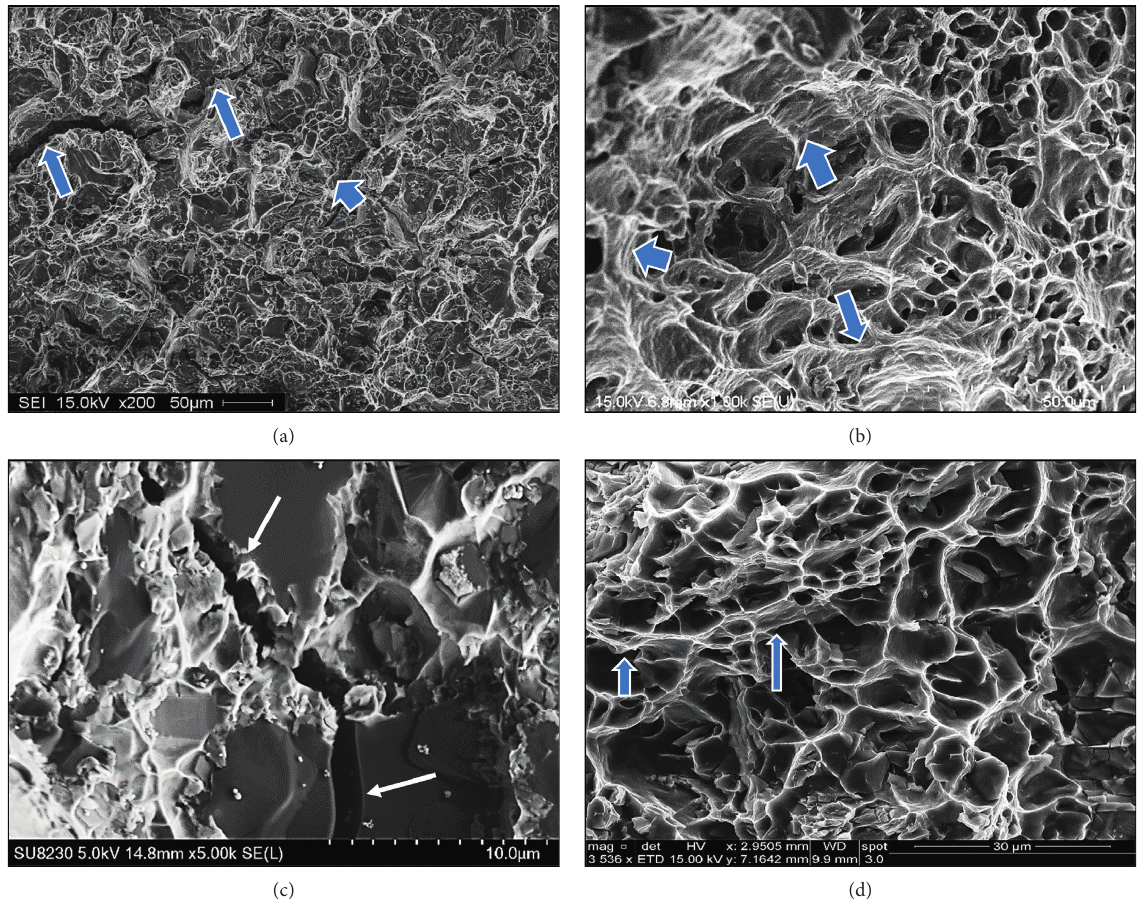
Figure 12: Secondary electron images (SEI) of the fracture surface of alloy (A). (a) as-cast condition (1.3% El), (b) SHTcondition (6.2% El),